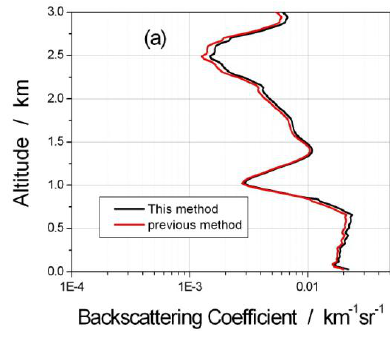
Fig. 3 Retrieved profiles of the aerosol backscattering coefficient from the two methods, at 19:00 LST on February 13,